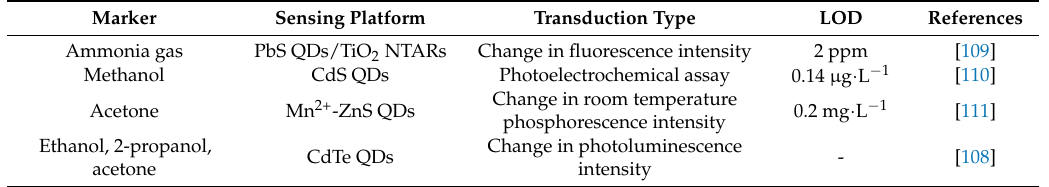
Table 9. QDs-based sensors for volatile substances